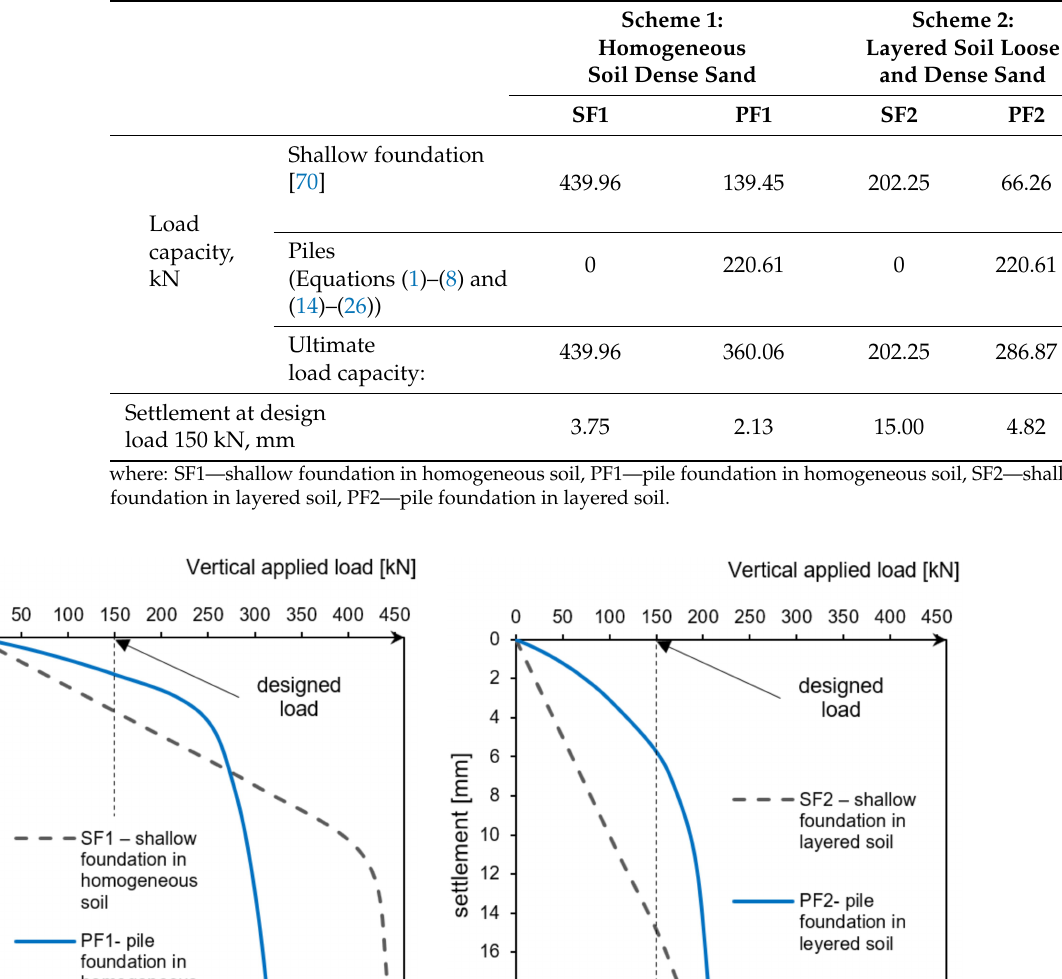
Table 8. The results of shallow and pile foundation calculation in homogenous/layered soil described in Figure 18.